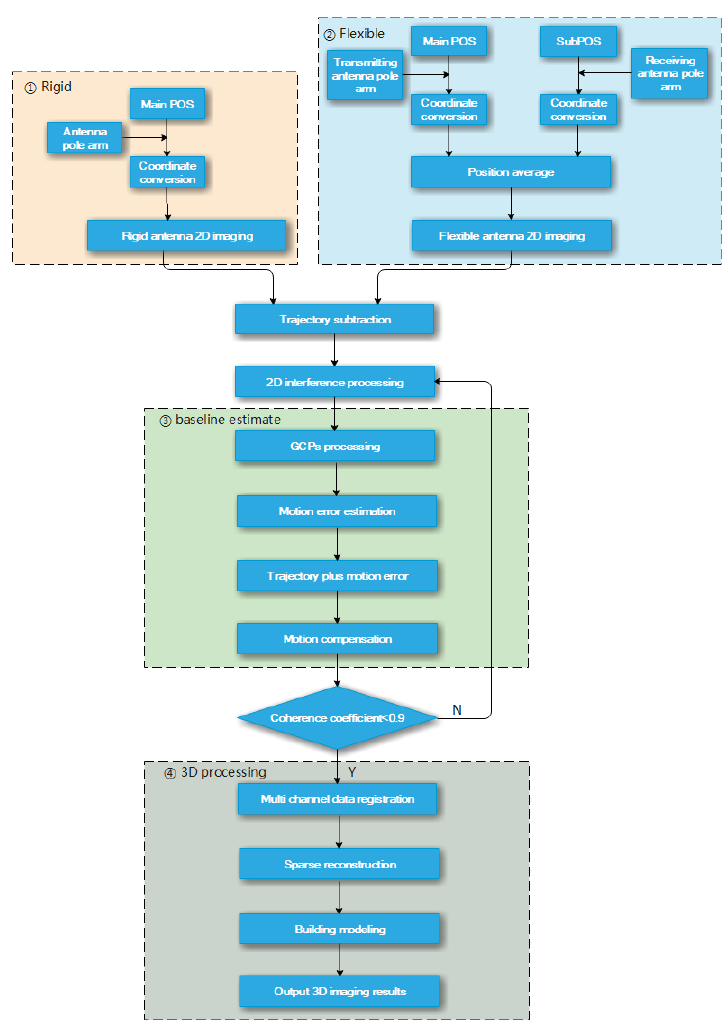
Figure 4. The improved 3D imaging